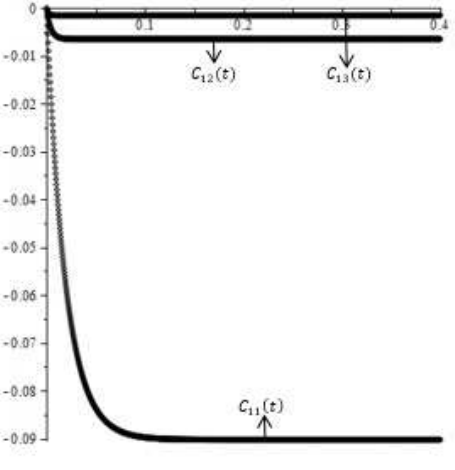
Fig. 1 First three approximation for time